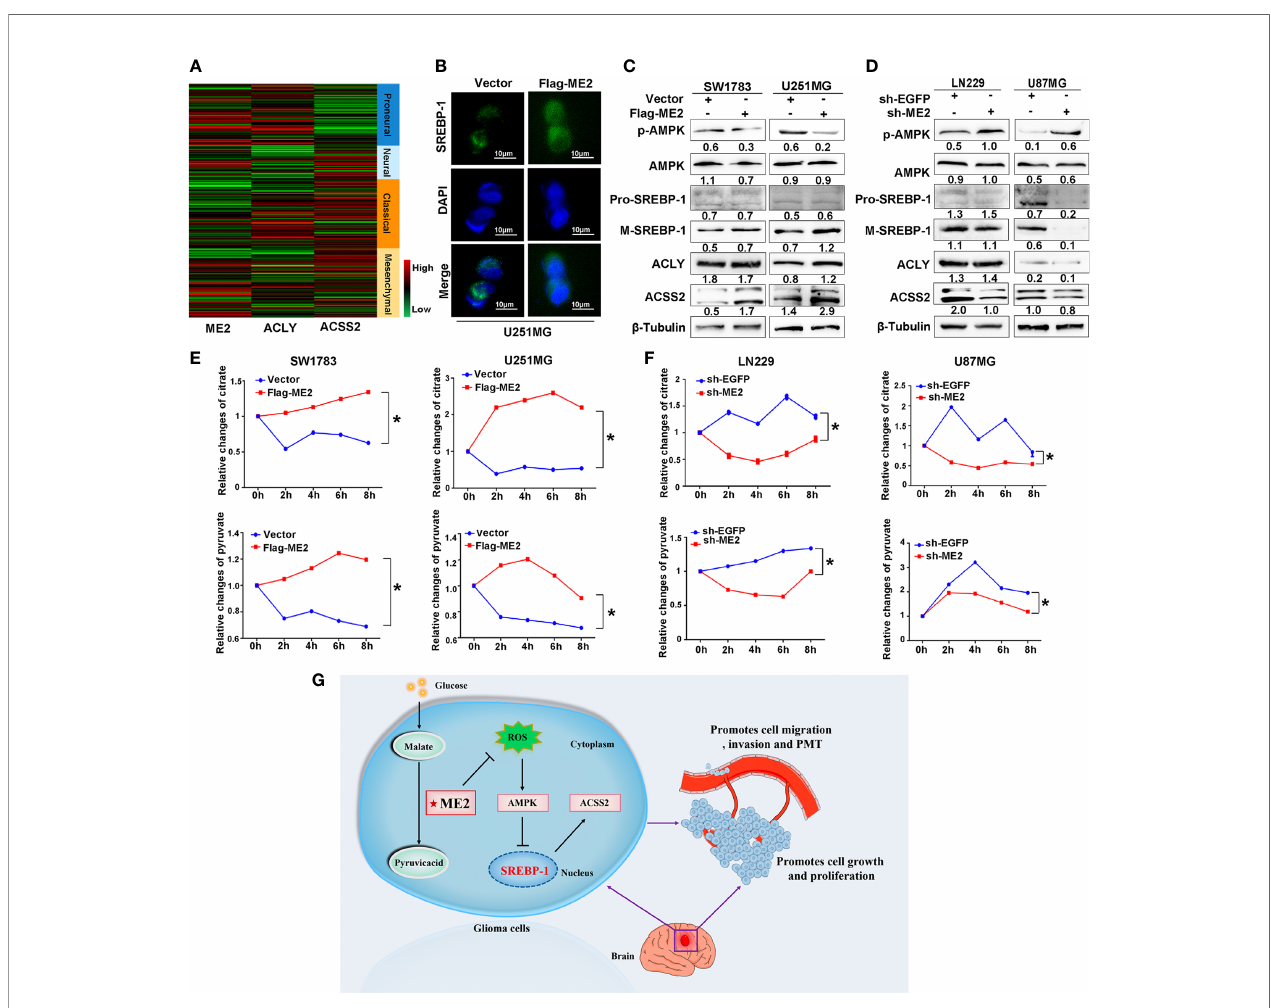
FIGURE 8 | ME2 promotes lipogenesis reprogramming in glioma cells. (A) Gene expression heat maps showing expression of ME2, ACLY, and ACSS2 in different gliomas. (B) Localization of SREBP-1 in U251MG cells observed by immuno fl uorescence staining. (C, D) Relative changes in citrate and pyruvate concentration (C) in SW1783 and U251MG cells and in (D) LN229 and U87MG cells transfected with various plasmids (*P < 0.05). (E, F) Changes in expression of proteins including p-AMPK, AMPK, pro-SREBP-1, M-SREBP-1, ACLY, and ACSS2 in (E) SW1783 and U251MG cells and in (F) U87MG and LN229 cells transfected with various plasmids. (G) Mechanistic diagram of the role of ME2 in